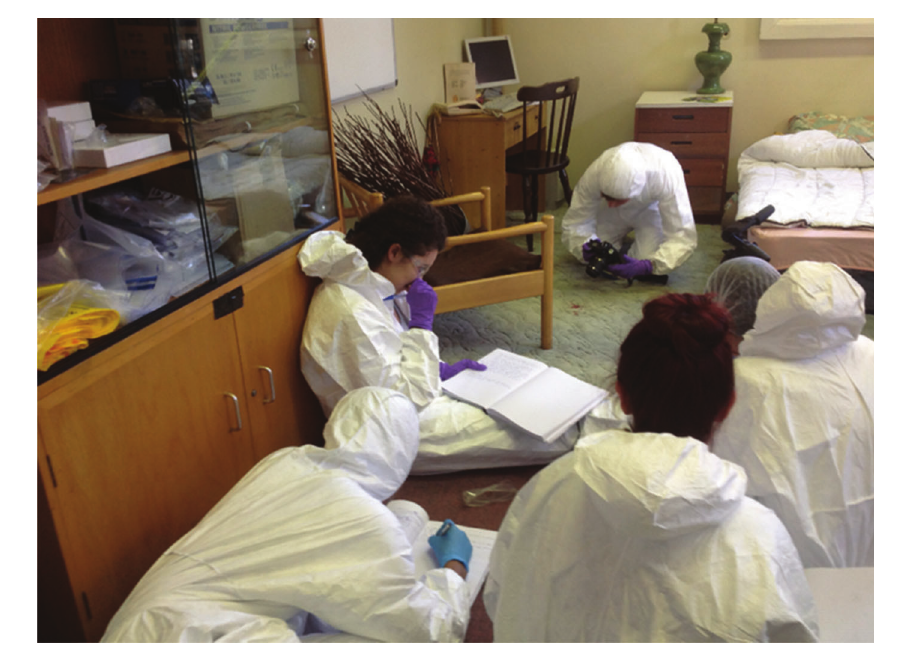
Figure 1: Forensic science students working on a collaborative task, February 2013 – photograph by the